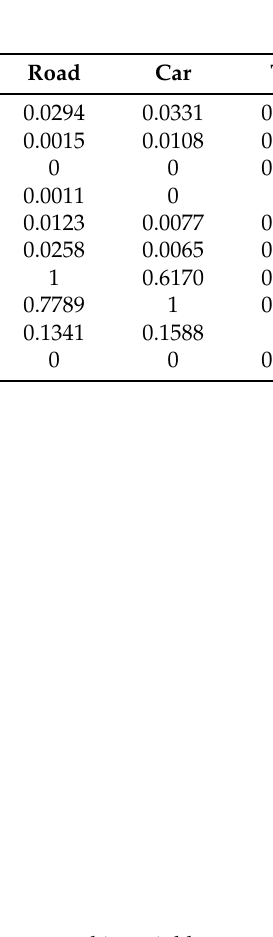
Figure 2. Illustration of the central connected component and its